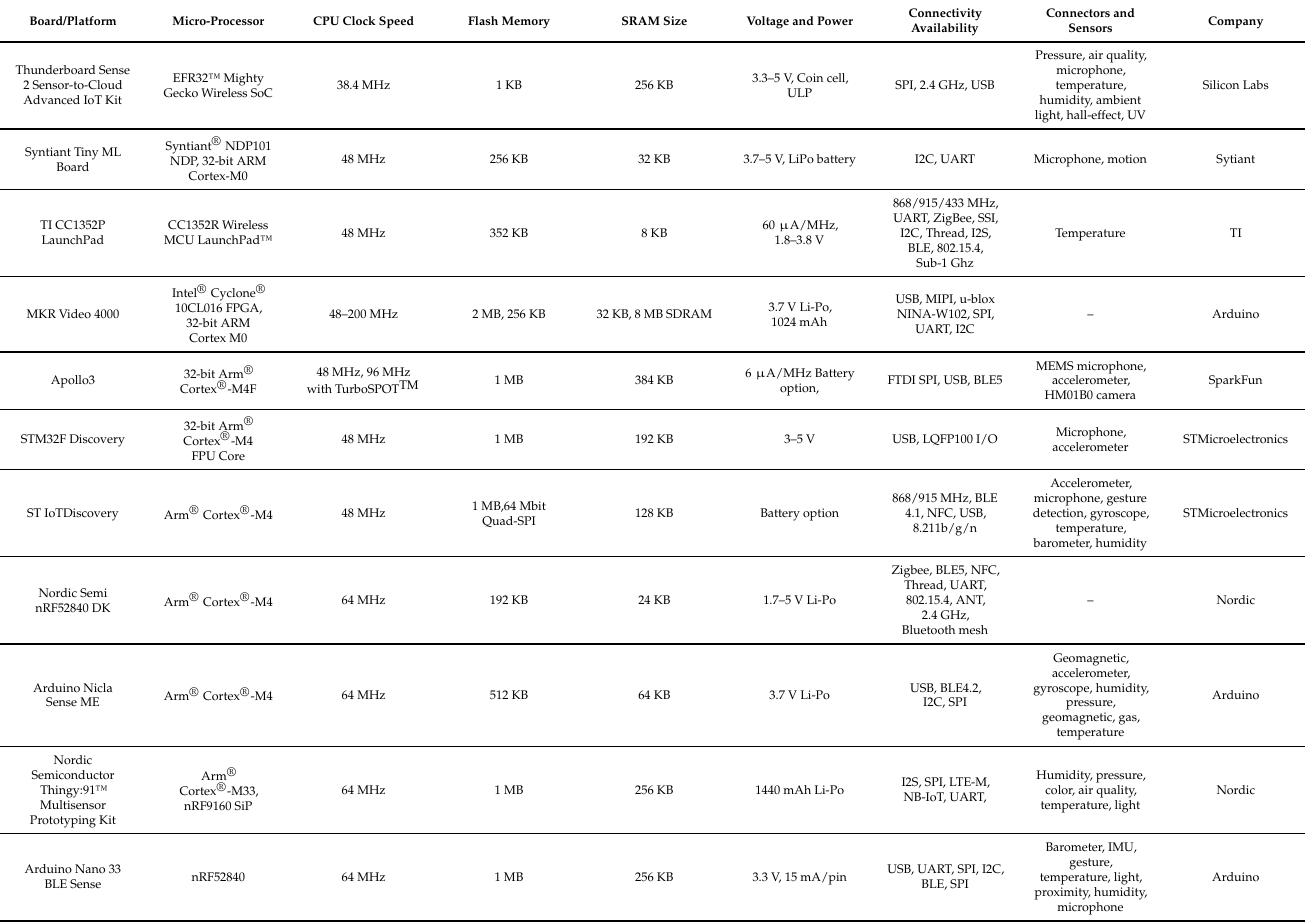
Table 2. Comparison of TinyML Supporting Hardware Platforms (CPU Clock < 100 Mhz).